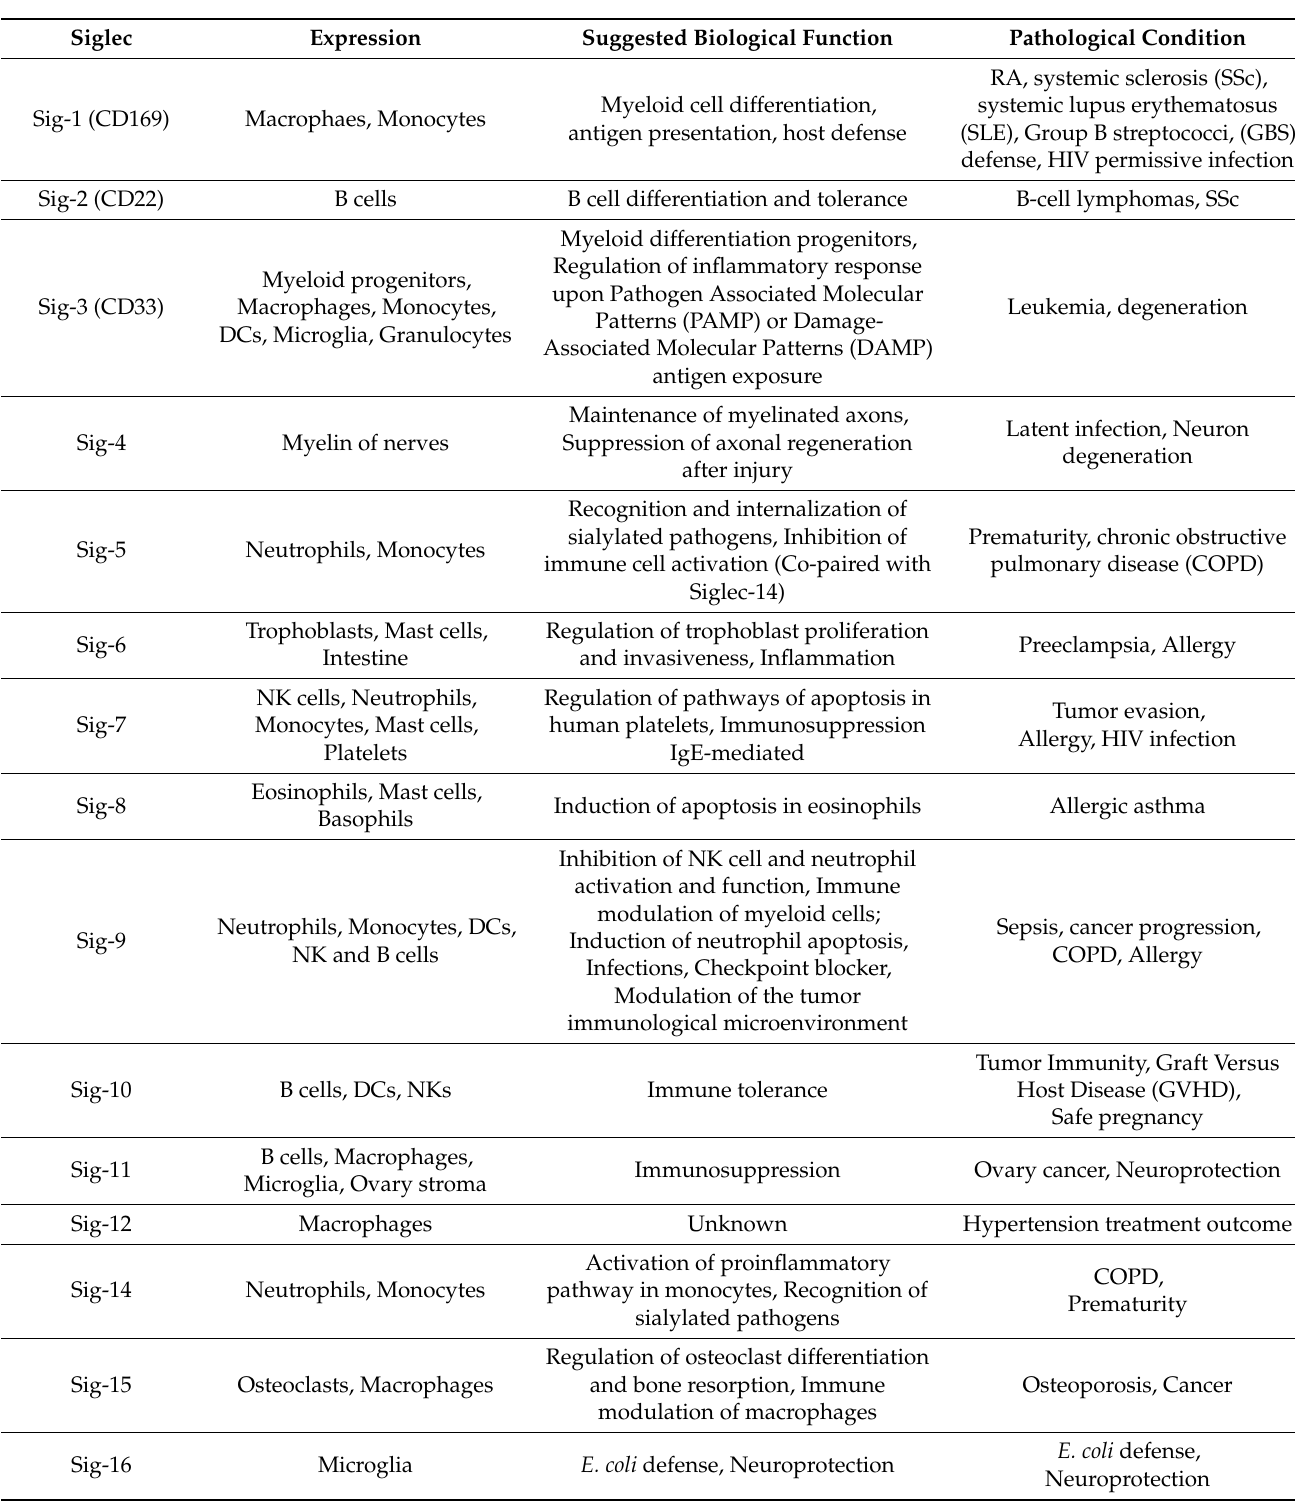
Table 1. Sialic acid-binding immunoglobulin-like lectin (Siglec) expression, biological function and correlation with pathological